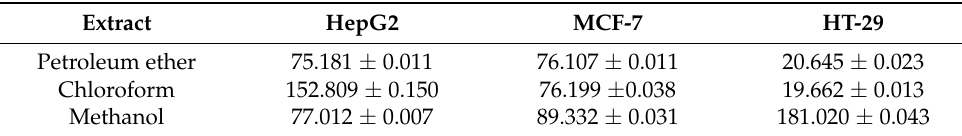
Table 3. Calculated IC 50 values of petroleum ether, chloroform and methanol crude extracts for different cell